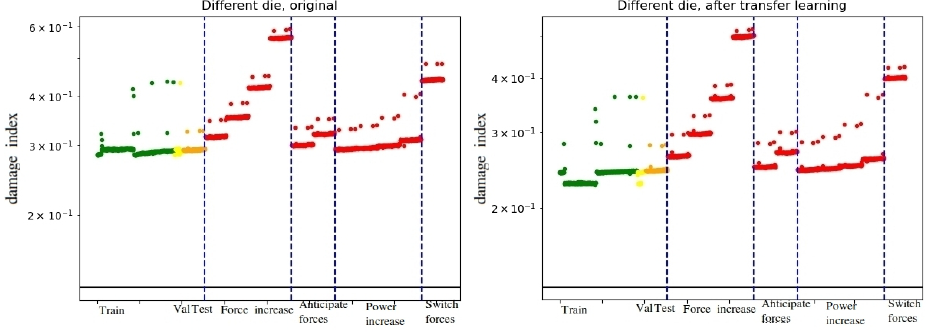
Figure 12. Damage indexes of train, validation, test correct, and test failure test data before ( left ) and after transfer learning ( right ) using 2D-CNN-AE model in data of different die. Correct damage indexes are represented in orange and failure damage indexes in red. Horizontal black line represents the anomaly detection threshold and dashed blue line splits data by each failure